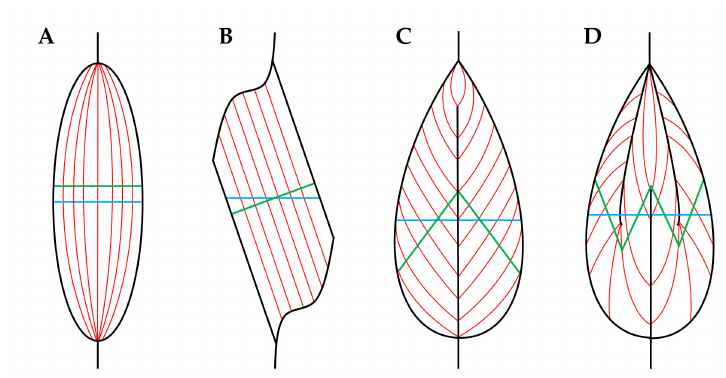
Figure 2. Various pennation angle arrangements of the fascicles / myofibers in skeletal muscle: ( A ) fusiform, ( B ) unipennate, ( C ) bipennante, ( D ) multipennate. Blue lines indicate the plane for the anatomical cross-sectional area (CSA) (i.e., the CSA that runs perpendicular to the longitudinal axis of the muscle), and green lines indicate the plane for physiological CSA (i.e., the CSA that runs perpendicular to the longitudinal axis of the fascicles / myofibers). Adapted under the Creative Commons Attribution-Share Alike 3.0 Unported license from original work by Uwe Gille (Available online: https: // creativecommons.org / licenses / by-sa / 3.0 / deed.en (accessed on 6 January